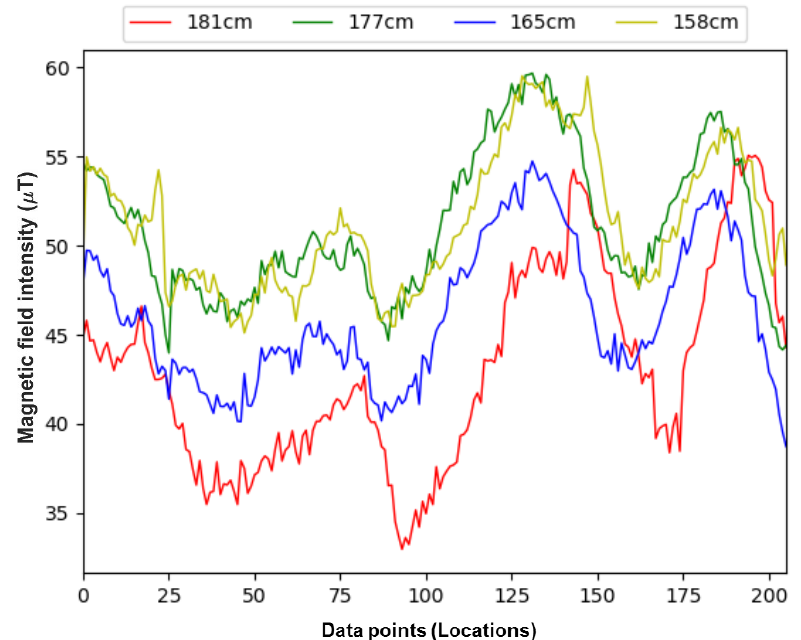
Figure 4. Impact of the users’ heights on the magnetic field data. The data collection scenario is the same where the data is collected during the same hour of the day. The x -axis shows the data points at different locations when the user is walking along the